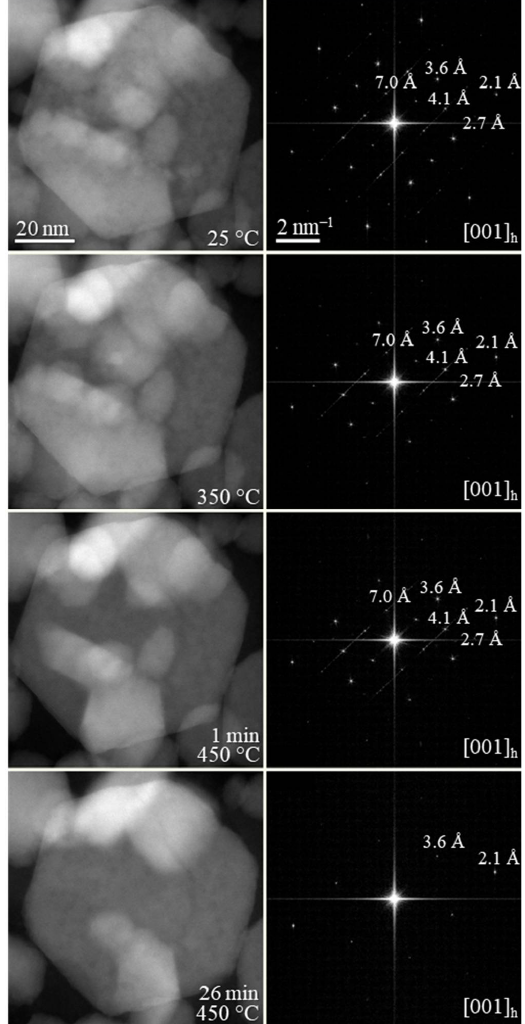
Figure 4. From top to bottom: in situ TEM imaging under vacuum of the synthesized Cu(In,Ga)Se 2 (CIGS) NPs at RT, at 350 °C, and at 450 °C during 1 and 26 min, along with the corresponding FFT patterns.